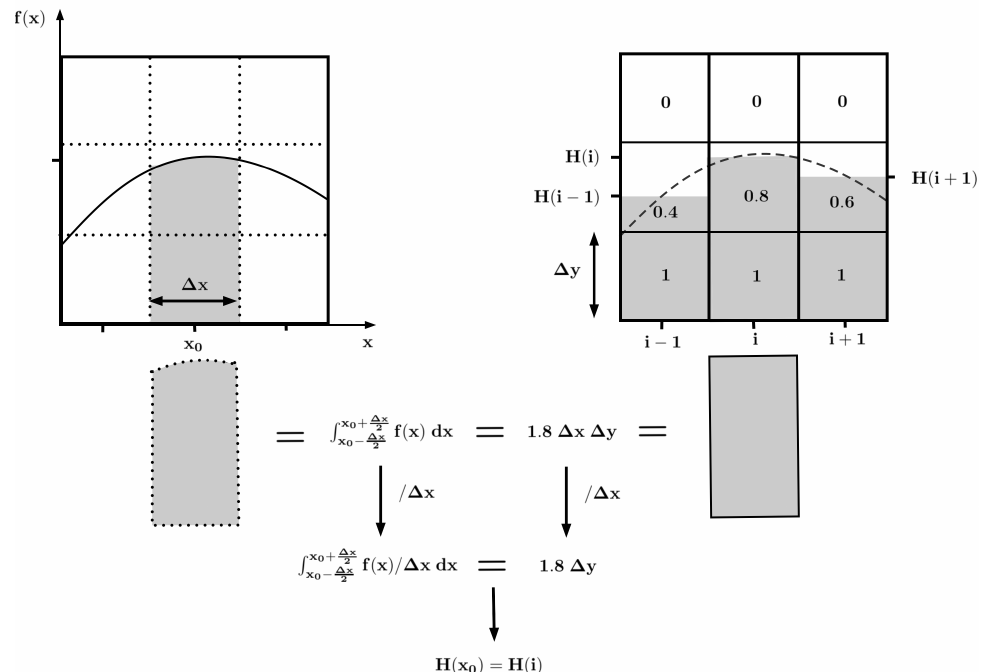
Figure 4. Methodology of height functions. The sum of the volume fractions present in a column is equal to the average value of a function f on an interval ∆ x of which the curve represents the